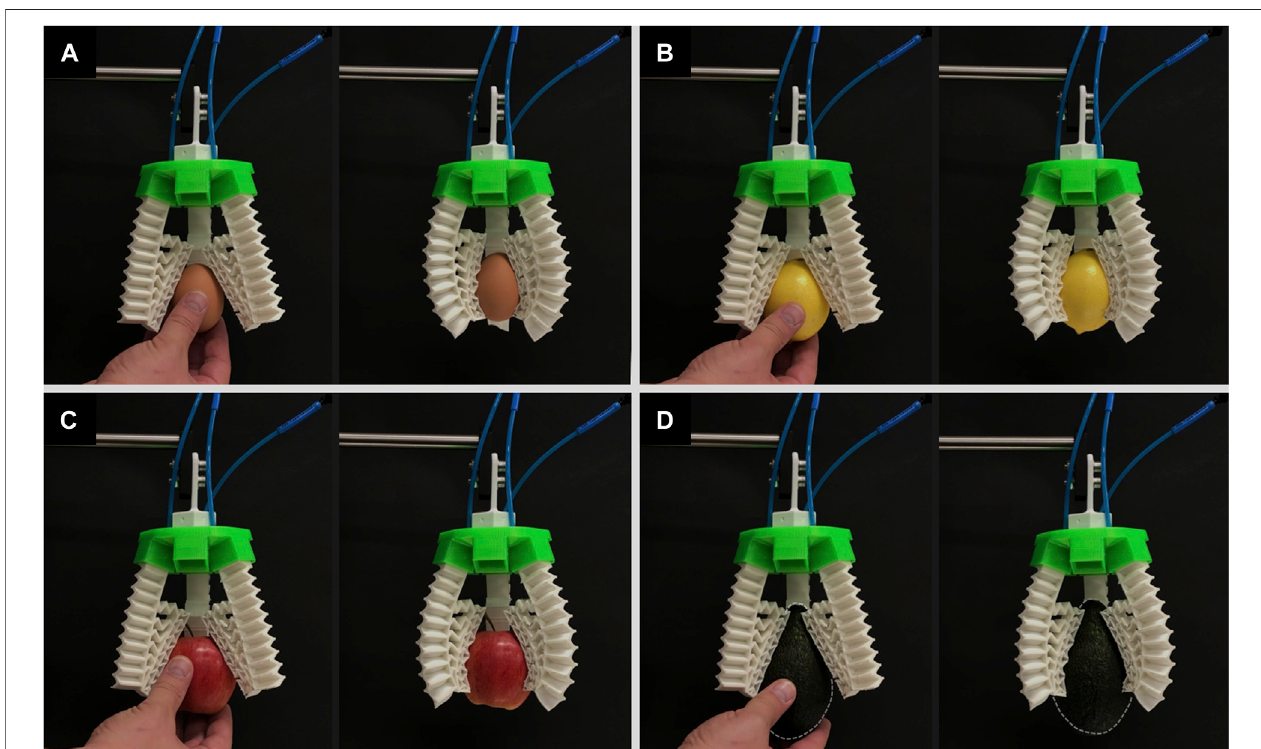
FIGURE10| Thesoftmodulargripperinathree- fi nger con fi guration withthemechanicalmetamaterialgraspingsuccessfully (A) anegg, (B) alemon, (C) anapple, and (D) an avocado.